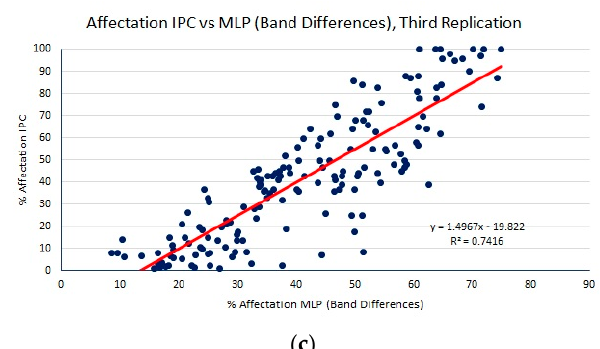
Figure 7. Percentage of P. infestans affectation using IPC methodology vs. estimated percentage of affectation using MLP on the band differences dataset, for ( a ) first replication, MAE: 12.03, RMSE: 15.05, R 2 : 0.7132; ( b ) second replication, MAE: 14.44, RMSE: 17.43, R 2 : 0.7846; ( c ) third replication, MAE: 13.21, RMSE: 16.38, R 2 : 0.7416.